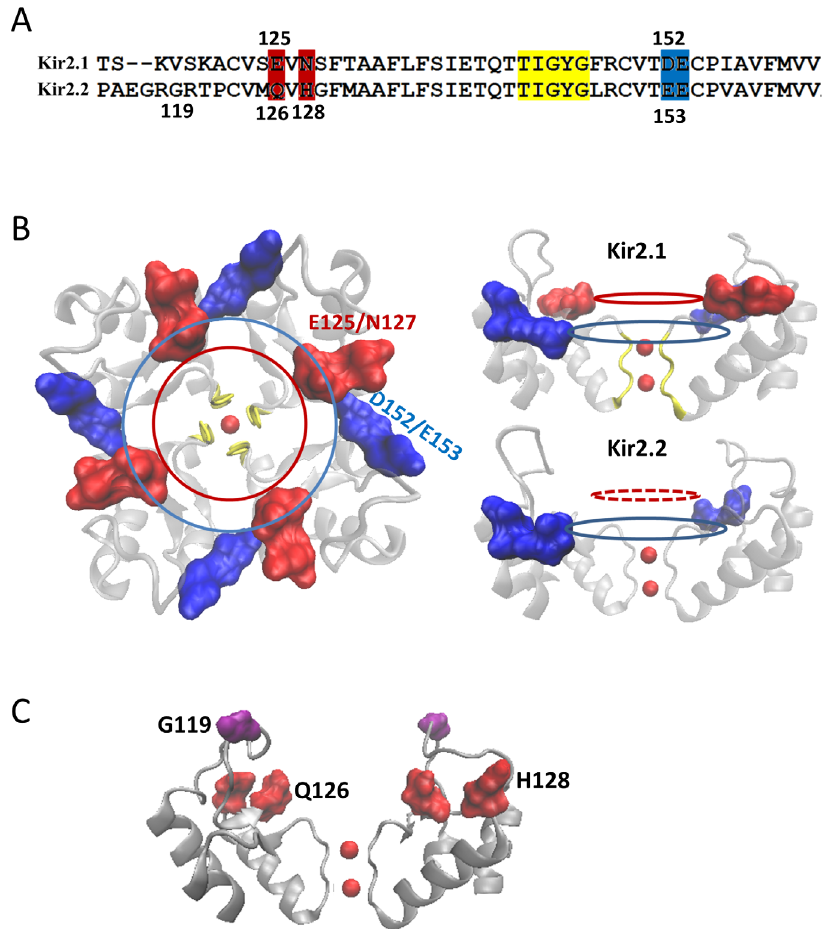
Figure 5. There is only one negative ring in Kir2.2 but two in Kir2.1. Sequence alignments for Kir2.1 and Kir2.2 (A) and the schematic positions of the negative rings (B). There are two negative rings in Kir2.1 formed by three negatively charged and one polar amino acid side chains which are E125 & N127 (highlighted in red circle), D152 & E153 (highlighted in blue circle). Whereas, Kir2.2 channel lacks one of the two negatively charged rings (red dotted line circle, bottom right). For clarity, only two of four subunits are shown. (C) Ribbon model of the extracellular side of two subunits of Kir2.2 showing the positions of G119 (purple), Q126 (red) and H128 (red).